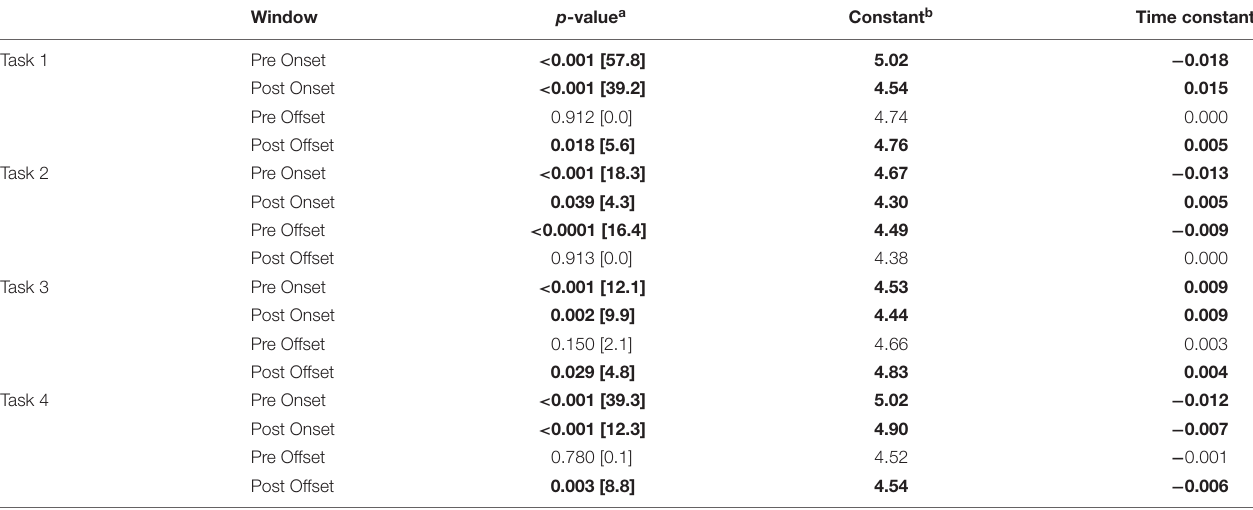
TABLE 7 | Exponential regression analysis of temporal trends in pupil diameter for each task phase.